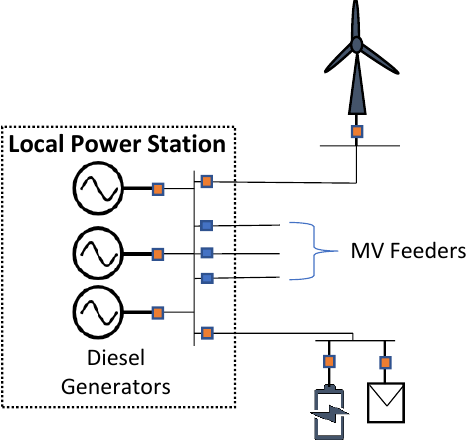
Figure 1. System topology for Astypalea.